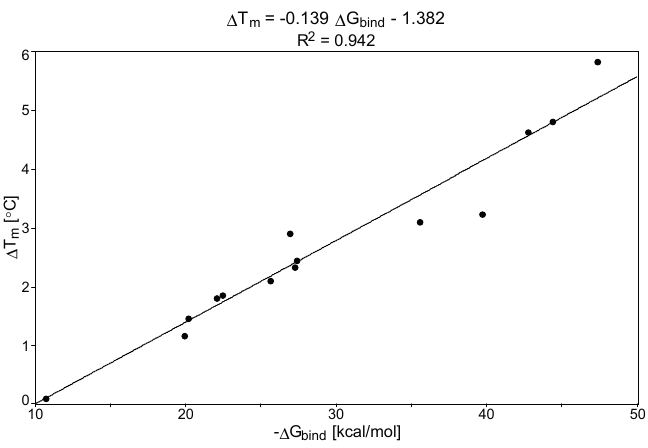
Figure 1. The plot of Δ T m versus theoretically estimated DNA free energy of binding ( − Δ G bind